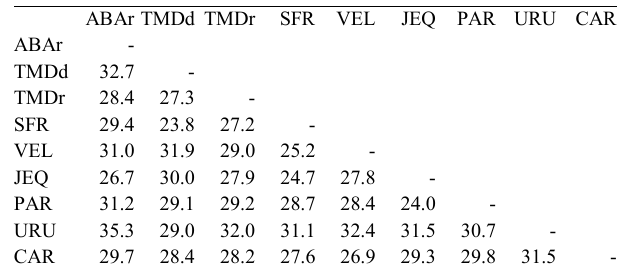
Table 5. Chord genetic distance among sampling of Prochilodus argenteus . Values in %. ABAr = rio Abaeté at rainy season; CAR = rio Carinhanha lagoons; JEQ = rio Jequitaí lagoons; PAR = rio Paracatu lagoons; SFR = rio São Francisco lagoons; URU = rio Urucuia lagoons; VEL = rio das Velhas lagoons; TMDd = Três Marias Dam at dry season; TMDr = Três Marias Dam at rainy season.